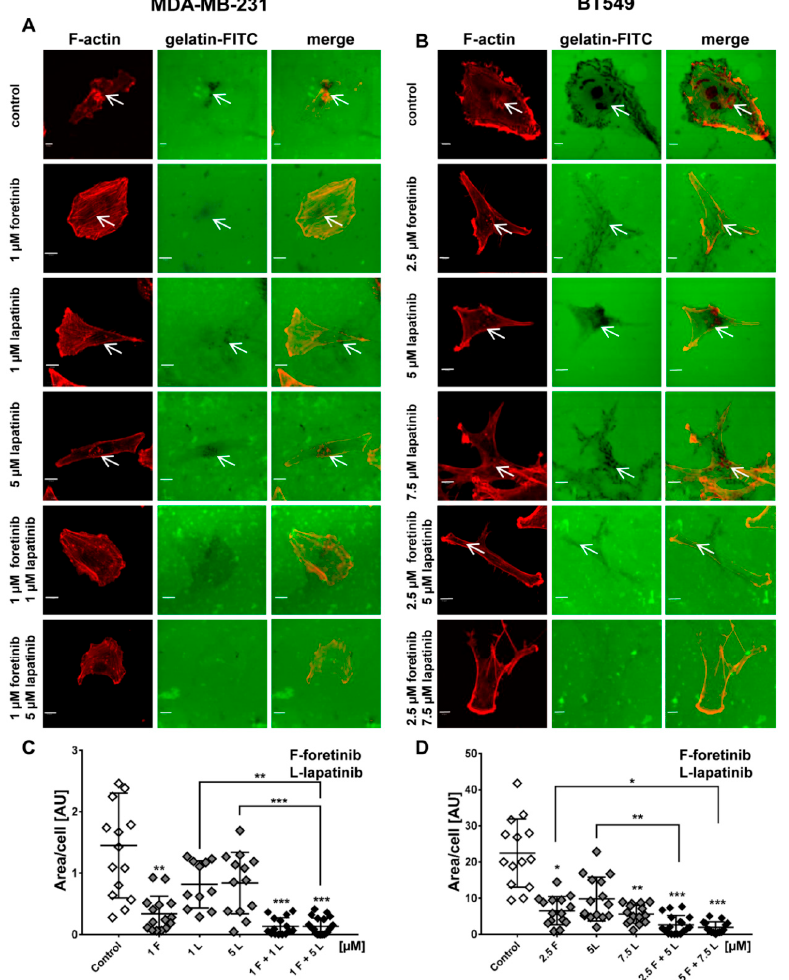
Figure 5. Influence of EGFR and MET inhibitors on the proteolytic activity of the ( A ) MDA-MB-231 and ( B ) BT549 cell lines. Cells were seeded on FITC-gelatin and after inhibitors treatment (12 h) they were fixed and stained for F-actin.Matrix degradation activity was identified by dark areas on the gelatin-FITC background. White arrows indicate invadopodia. Scale bar: 10 µM. The areas digested by ( C ) MDA-MB-231 and ( D ) BT549 cells were calculated using ImageJ software. Asterisks indicate differences between control and treated cells or between cells treated with different drugs. The significance level was set at p ≤ 0.05 (*), p ≤ 0.01 (**), or p ≤ 0.001 (***).